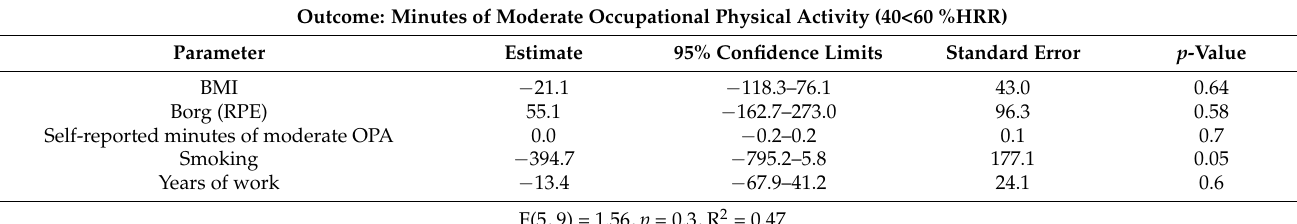
Table 7. Multiple linear regression model for directly measured minutes of moderate OPA per